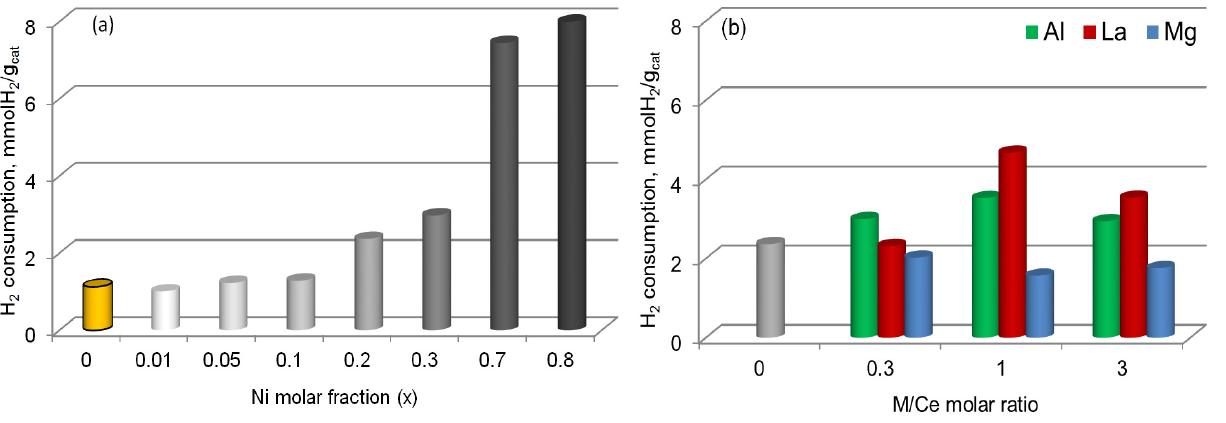
Figure 11. The effect of Ni molar fraction ( a ) and M/Ce molar ratio ( b ) on the total H 2 consumption rate. ( a )—M/Ce molar ratio is equal to 0; ( b )—Ni molar fraction is equal to 0.2.